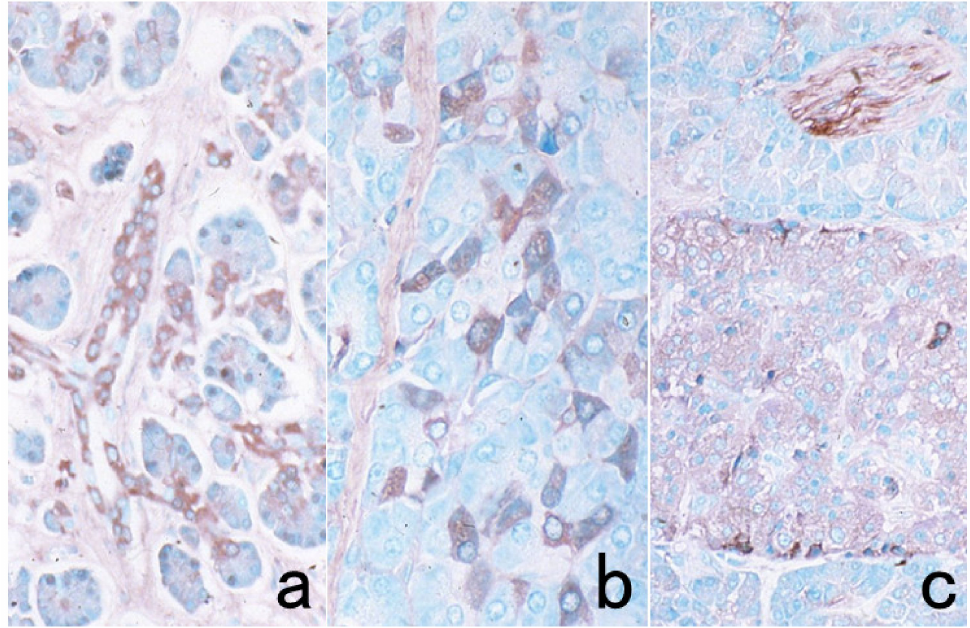
Figure 13. Diffusion artifact (III). Albumin immunoreactivity in FFPE autopsied pancreas. Ductular cells ( a ), acinar cells ( b ), and islet cells and peripheral nerve ( c ) show diffuse cytoplasmic staining. The signals are randomly observed in different cells in different parts of the pancreas. The nuclei, counterstained with methyl green, remain